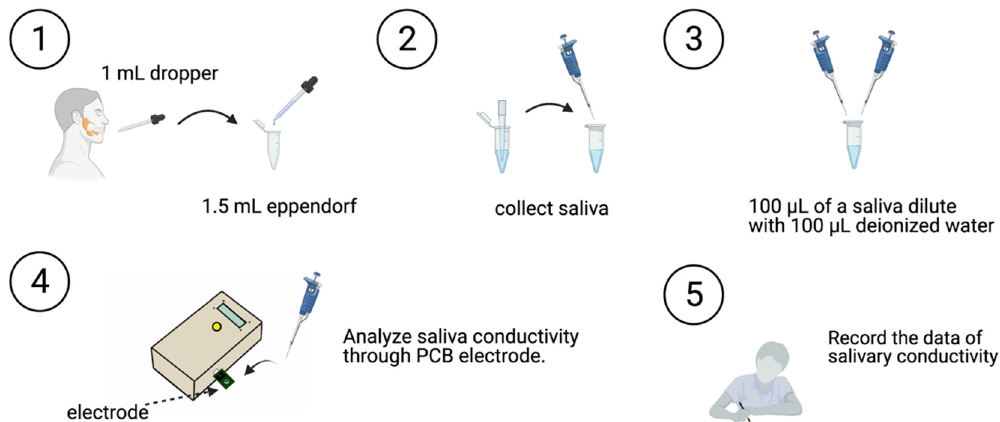
Figure 2. The salivary collection and analysis protocol. Salivary conductivity is detected using a printed-circuit board biodevice. ① : Saliva was collected with a 1-mL dropper. ② : The collected salivary sample was placed in a 1.5 mL Eppendorf tube. ③ : The saliva sample (100 μ L) was then diluted with 100 μ L of deionized water. ④ : Saliva conductivity was then analyzed using the developed portable monitor with a disposable printed-circuit board (PCB) electrode. ⑤ : Data on salivary conductivity was then recorded.